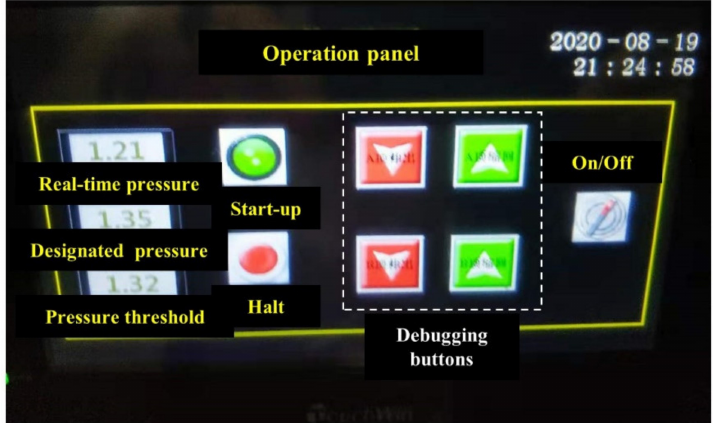
Figure 6. Photographs of the interactive